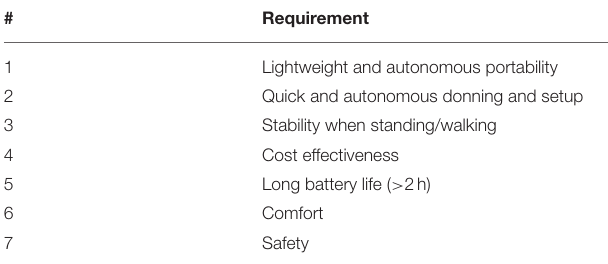
TABLE 2 | Requirements of the TWIN